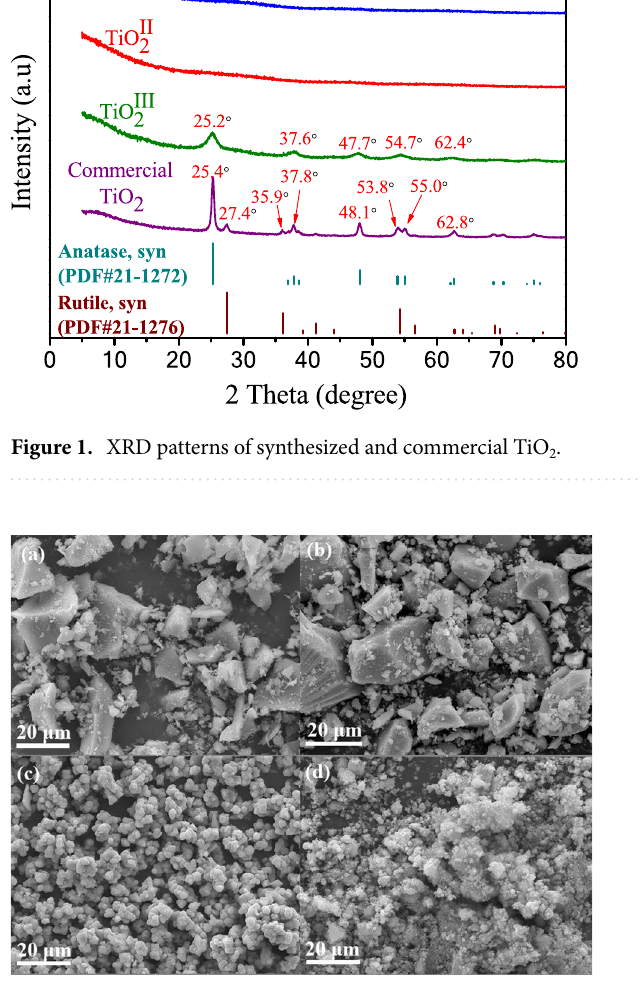
Figure 2. SEM images of TiO 2 I ( a ), TiO 2 II ( b ), TiO 2 III ( c ) and commercial TiO 2 ( d